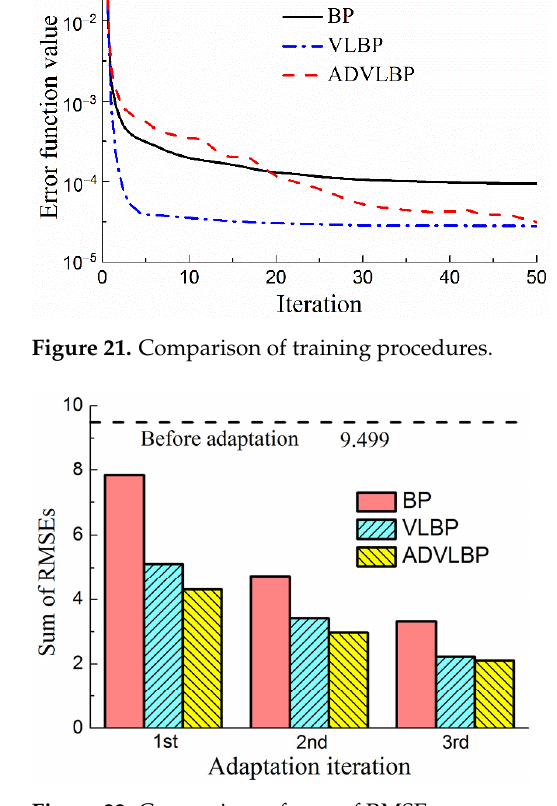
Figure 22. Comparison of sum of RMSEs.